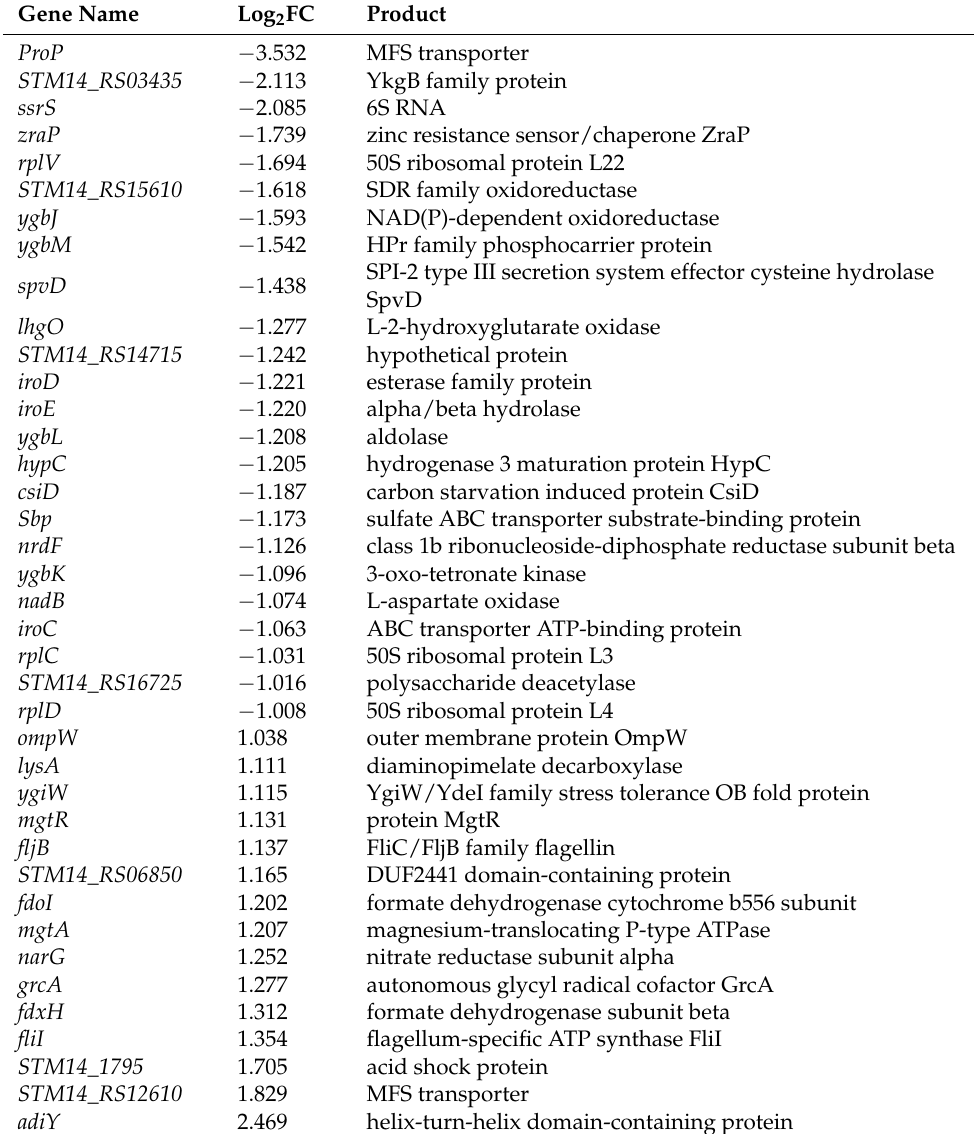
Table 1. Differentially expressed genes (DEGs) between WT and ∆